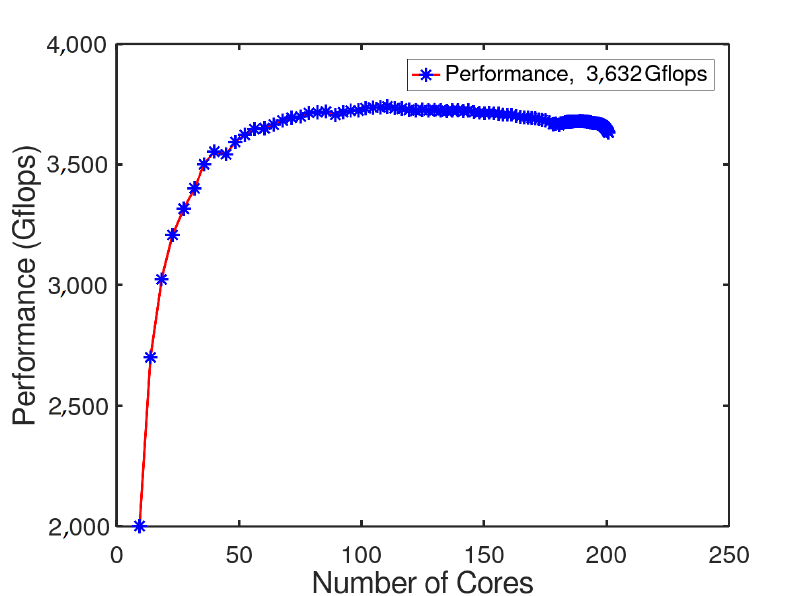
Figure 8. Power vs.